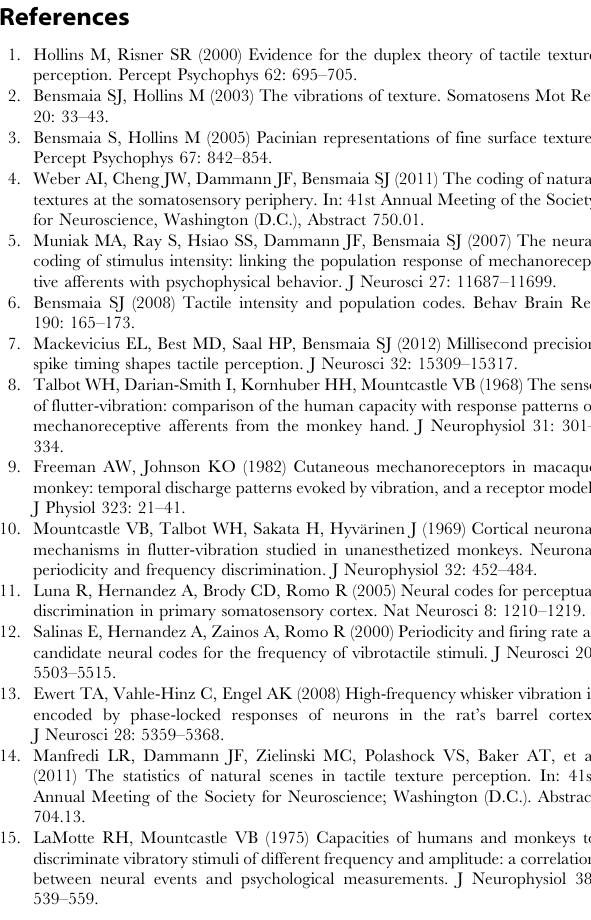
Figure S7 Predicting psychophysical responses from stimulus features. Predicted versus perceived dissimilarity as calculated from (A) (log) stimulus amplitude, and (B) (log) stimulus amplitude and spectral centroid (average frequency, weighted by power). Symbols as in Figure 6. (EPS) Figure S8 Specific information about each frequency computed from amplitude for sinusoids. The specific information about frequency in the amplitude reflects the fact that different amplitudes were used at different frequencies. If the rates encode amplitude (and not frequency), this is the shape of the function we would expect in Figure 5B, which bolsters the argument that rates do not encode frequency.